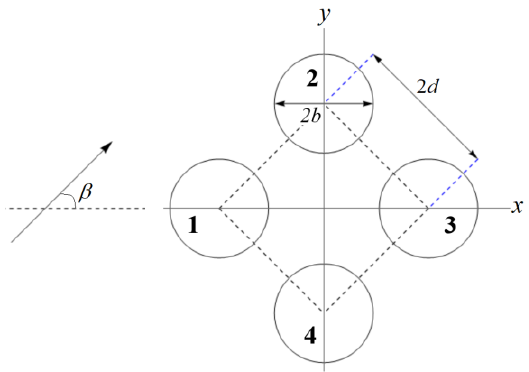
Figure 2. Configuration of the cylinders.